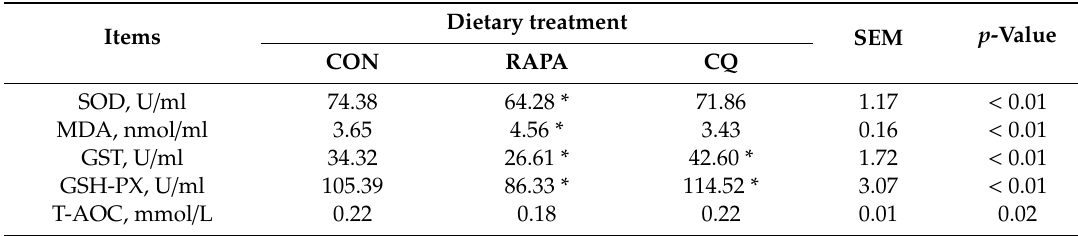
Table 5. Plasma antioxidant index.